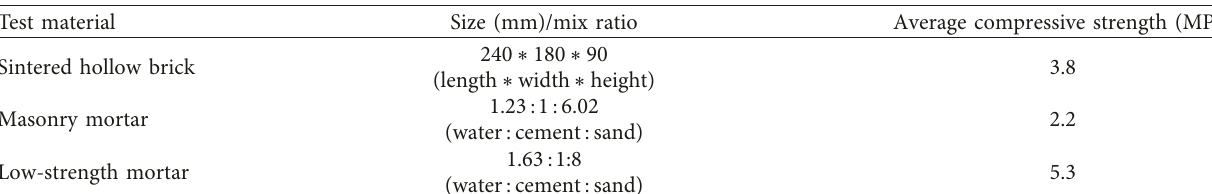
Figure 5: Material mechanical properties test. (a) Mortar mechanics test. (b) Mechanical properties test of sintered hollow brick. Table 1: Test material measured compressive strength.